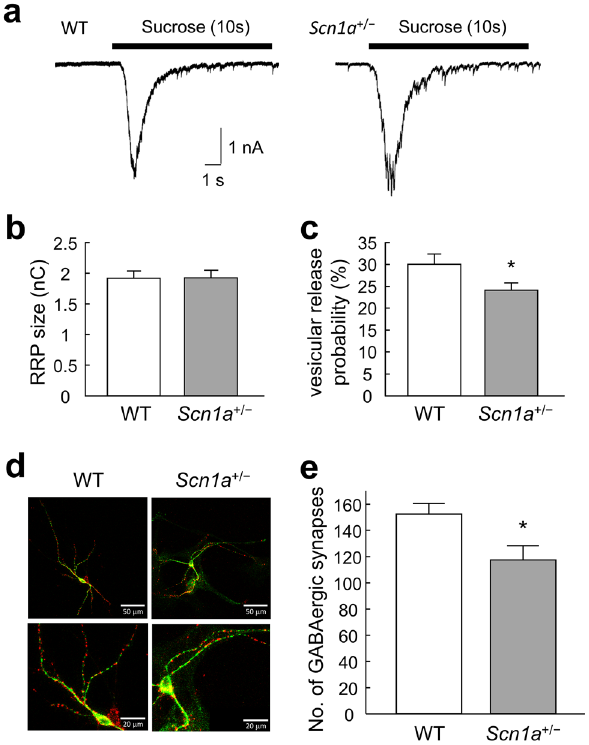
Figure 4. Changes in the number of inhibitory synapses in Scn1a +/− neurons. ( a ) Representative traces of responses to 0.5 M hypertonic sucrose solution (10 s, black bar) in an autapse neuron of either wild-type (WT) or Scn1a +/− mice. ( b ) The size of the readily releasable pool (RRP) of autaptic neurons of either WT or Scn1a +/− mice (WT: 1.91 ± 0.12 nC, n = 91; Scn1a +/− : 1.92 ± 0.12 nC, n = 92/ N = 5 cultures). ( c ) Vesicular release probability (P vr ) in single autaptic neurons of either WT or Scn1a +/− mice (WT: 29.99 ± 2.31%, n = 91; Scn1a +/− : 24.01 ± 1. 66%, n = 92/ N = 5 cultures, * p < 0.05). ( d ) Representative images of autaptic neurons immunostained for the inhibitory nerve terminal marker vesicular GABA transporter (VGAT; red) and the dendritic marker microtubule-associated protein 2 (MAP2; green). Parts of the top row (scale bar 50 μm) are enlarged in the bottom row (scale bar 20 μm). ( e ) The number of VGAT–positive synaptic puncta in autaptic neurons of either WT or Scn1a +/− mice (WT: 152.23 ± 7.91, n = 70, Scn1a +/− : 117 ± 10.61, n = 74/ N = 8 cultures, * p <